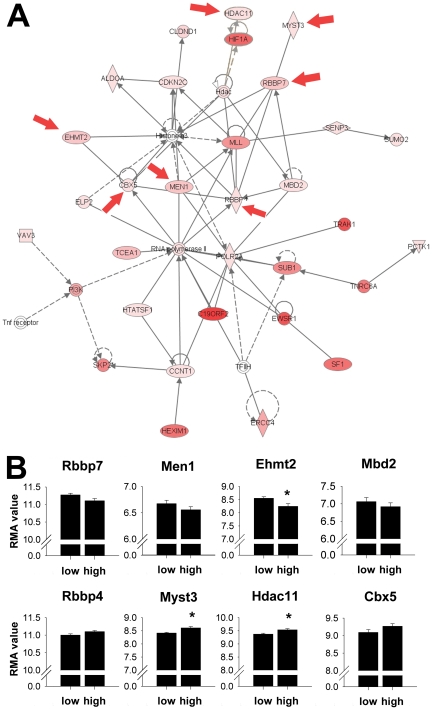
Chromatin modification genes differentially regulated in the nucleus accumbens of ethanol drinking mice. A.Network of genes involved in chromatin modification generated through the use of Ingenuity Pathways Analysis (www.ingenuity.com). Red arrows indicate genes identified in Gene Ontology Biological Process for establishment and/or maintenance of chromatin architecture. Genes significantly correlated to ethanol drinking are colored pink to red based on significance. Solid arrowheads reflect “acts on” interactions while lines without arrow indicate binding interactions only. Solid and dotted lines indicate, respectively, direct vs. indirect interactions. B. RMA expression of transcripts in networks involved in chromatin architecture. Low and high refer to the lowest vs. highest quartiles of ethanol drinkers. * p<0.05 by t-test.